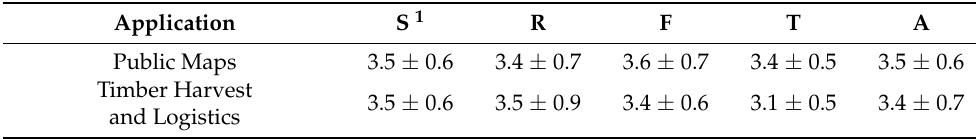
Table A3. Importance of the web mapping